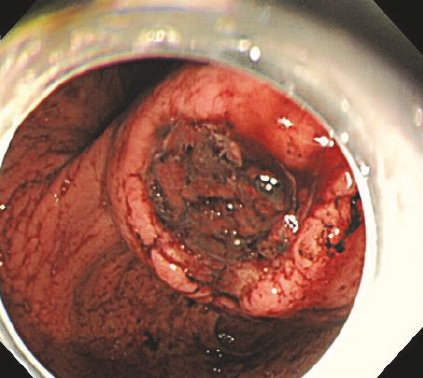
Figure 1: Gastroscopy revealed a submucosal-like tumor on the posterior wall of gastric angle with superficial ulceration.